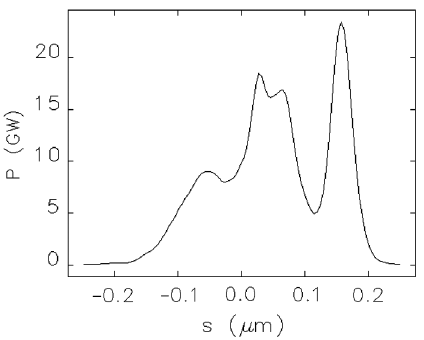
FIG. 10. FEL power temporal profile at 20 m into the undulator.